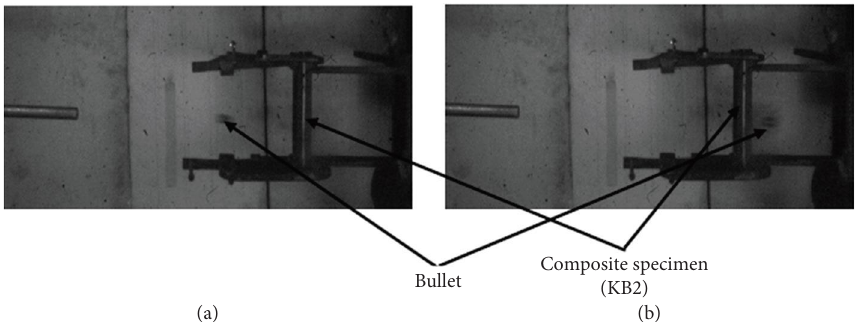
Figure 8: KB2 placed for testing: (a) KB2 before the impact and (b) KB2 bullet after the